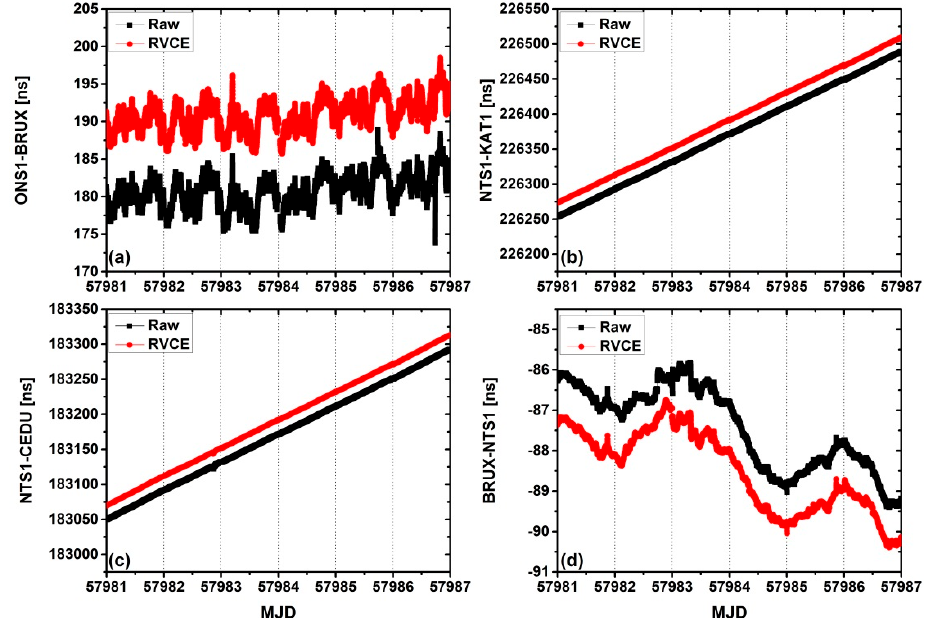
Figure 4. Results of time transfers determined by a carrier-phase (CP) technique with and without the RVCE approach for the four time links. ( a ) is for ONS1-BRUX, ( b ) is for NTS1-KAT1, ( c ) is for NTS1- CEDU and ( d ) is for BRUX-NTS1. NTS1-CEDU and ( d ) is for